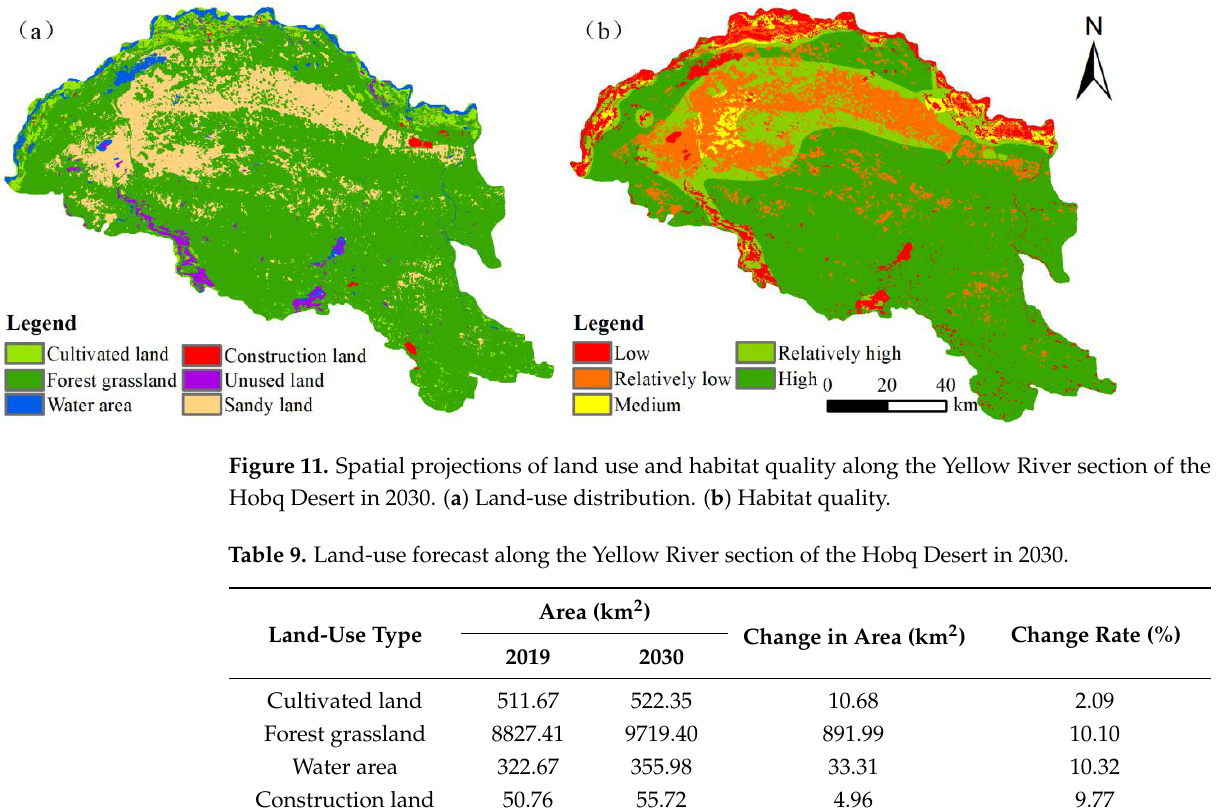
Table 10. Habitat quality forecast along the Yellow River section of the Hobq Desert in 2030.